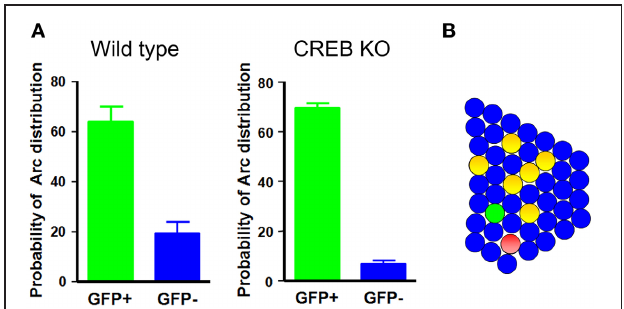
FIGURE 1 | Neurons with increased CREB function in the LA are preferentially recruited into the fear memory trace. (A) In wild-type and CREB-deficient mice, neurons injected with CREB are about 3- and 10-times more likely, respectively, to be Arc-positive than their neighbors. (B) A schematic illustration of the LA network. Green circles, CREB-positive neurons; red circles, Arc-positive neurons; yellow circles, double-positive